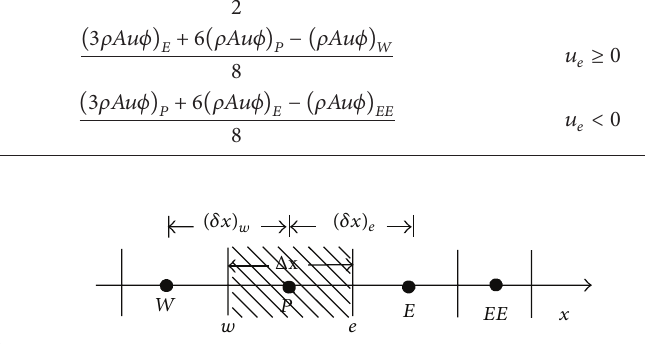
Figure 1: Sketch map of discrete